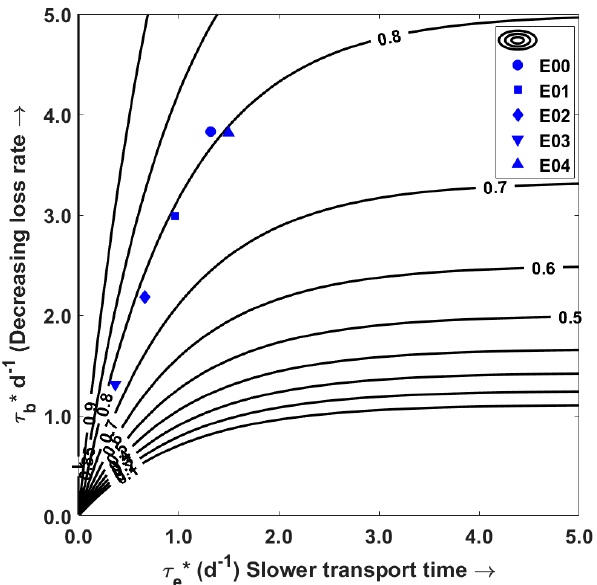
Figure 6. Normalized DO distribution under different conditions at Station LE5-4 (counters are O: Os, the ratio of the bottom-layer DO to surface-layer DO; circle represents E00; square represents E01; diamond represents E02; downward-pointing triangle represents E03; upward-pointing triangle represents E04).